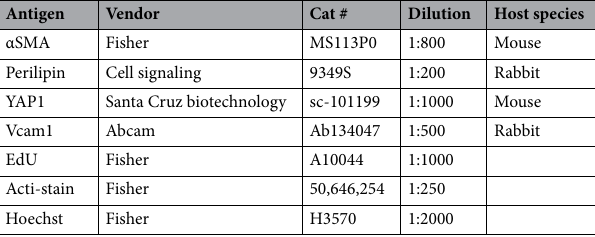
Table 1. Antibodies used for